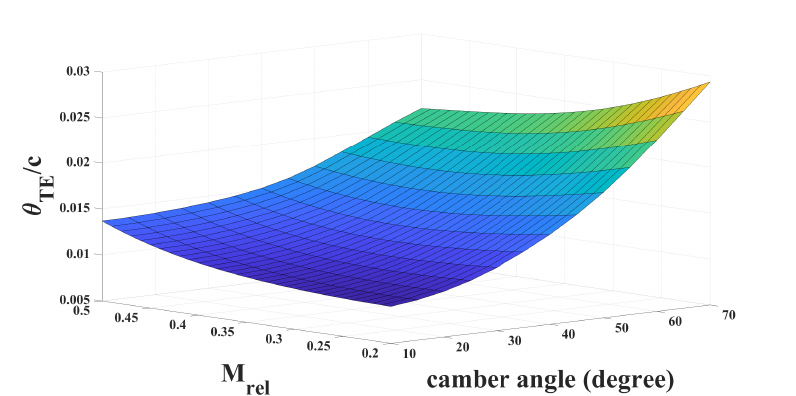
Figure 11. Momentum thickness prediction with ANN for a range of camber angles beyond the defined range in training—all other parameters correspond to cascade 1.